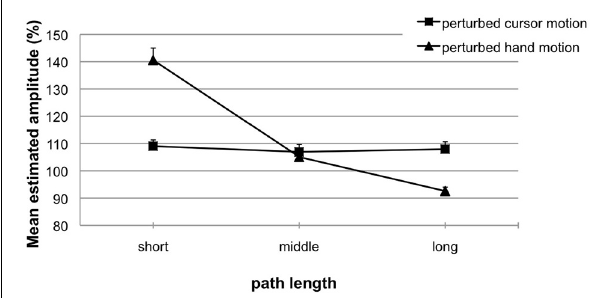
FIGURE 5 | Experiment 2. Mean estimated amplitude (%) for perturbed cursor motions (squares) and perturbed hand motions (triangles) as a function of length variation. A performance of 100% indicates exact replications. Error bars represent the standard error of the